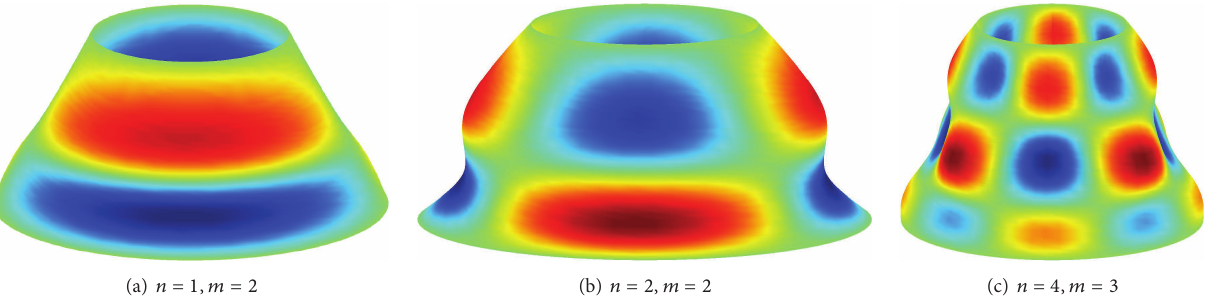
Figure 4: Modal shapes of the conical shell under S-S boundary conditions.